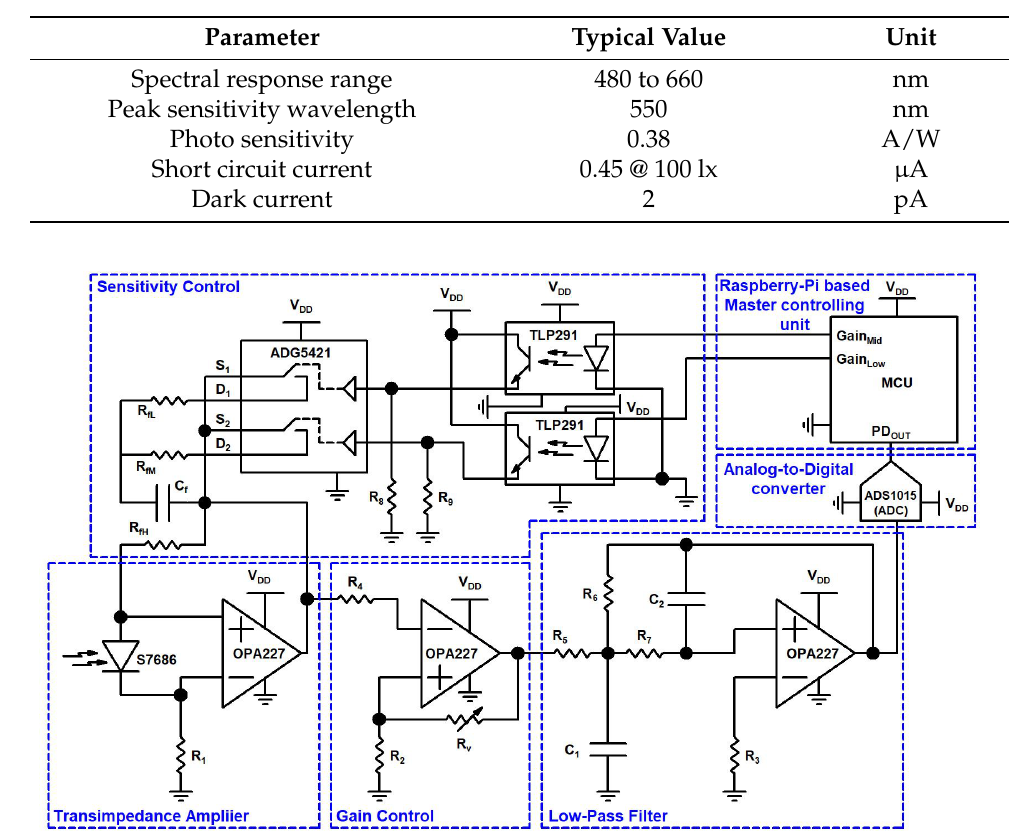
Table 1. Electrical and optical characteristics of the S7686.